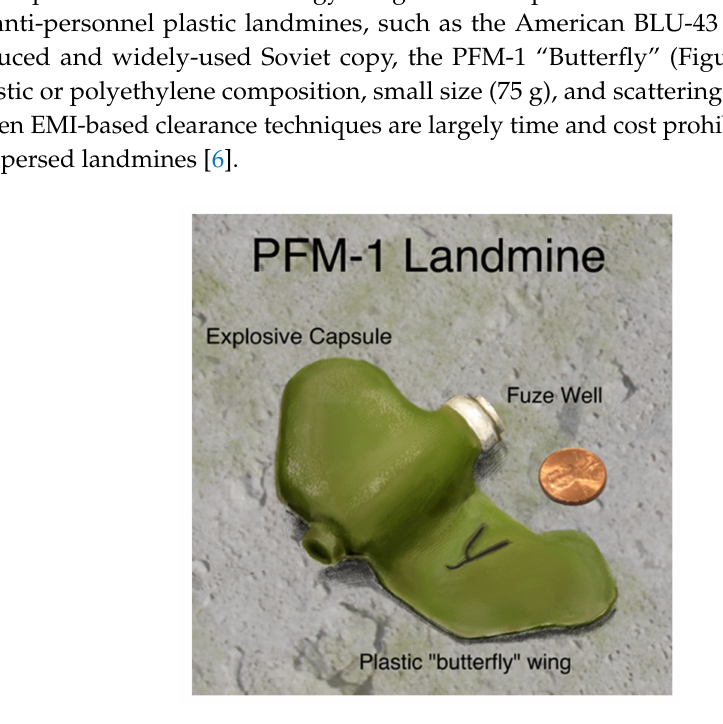
Figure 1. Rendering of an Inert PFM-1 plastic anti-personal landmine considered in this study with small US coin for